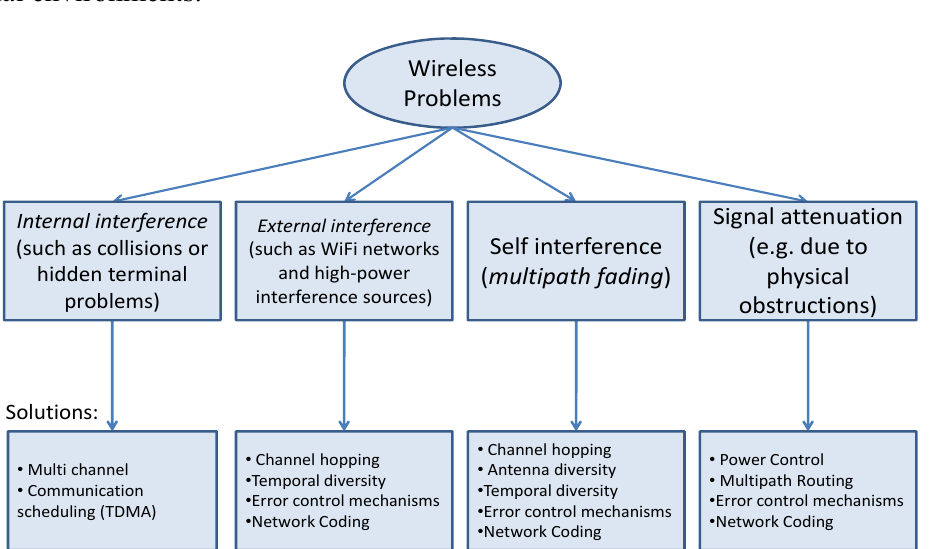
Figure 1. Common wireless communication problems and relevant solutions in typical industrial